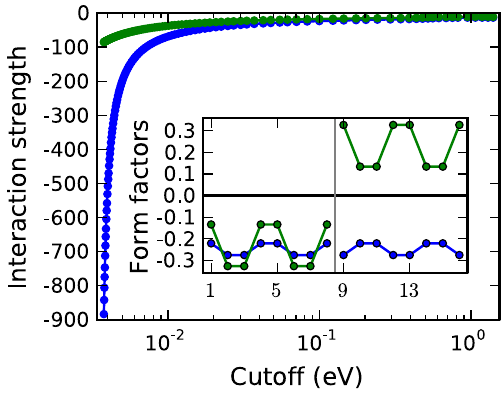
FIG. 8. Typical RG flows and the superconducting gaps asso- ciated with the Fermi surfaces for the two-pocket scenario with Þ ¼ ð 0 : 1 ; 0 : 5 Þ eV . Leading form factor is denoted in blue, ð J ;J 1 2 subleading form factor in green.